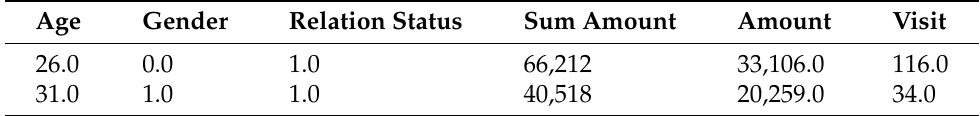
Table 6. Need based Package for Category